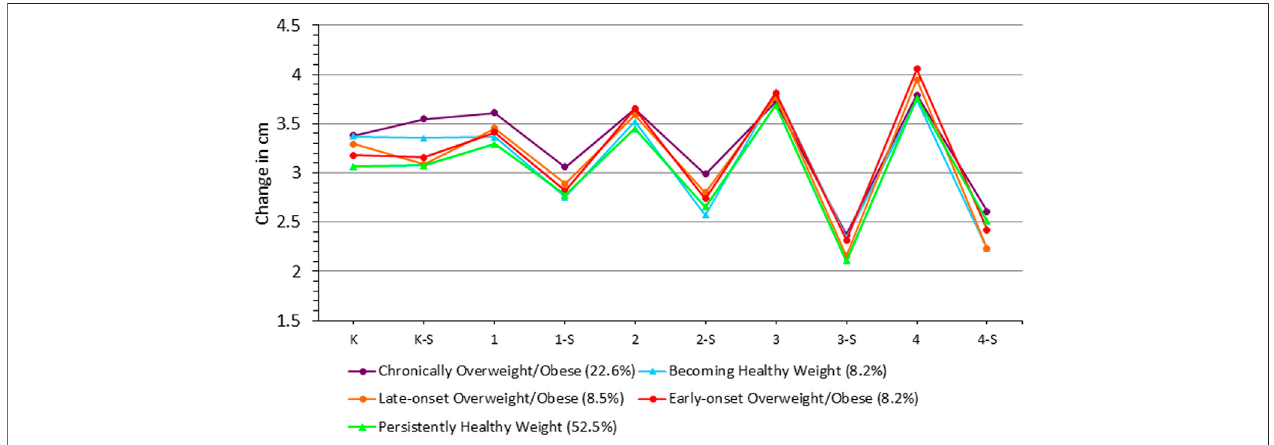
FIGURE 3| Seasonal variability in height gain across trajectory groups (means adjusted for age (months), season, sex, and race/ethnicity). K: Kindergarten School Year;K-S:KindergartenSummer;1:1stGradeSchoolYear;1-S:1stGradeSummer;2:2ndGradeSchoolYear;2-S:2ndGradeSummer;3:3rdGradeSchoolYear;3- S: 3rd Grade Summer; 4: 4th Grade School Year; 4-S: 4th Grade